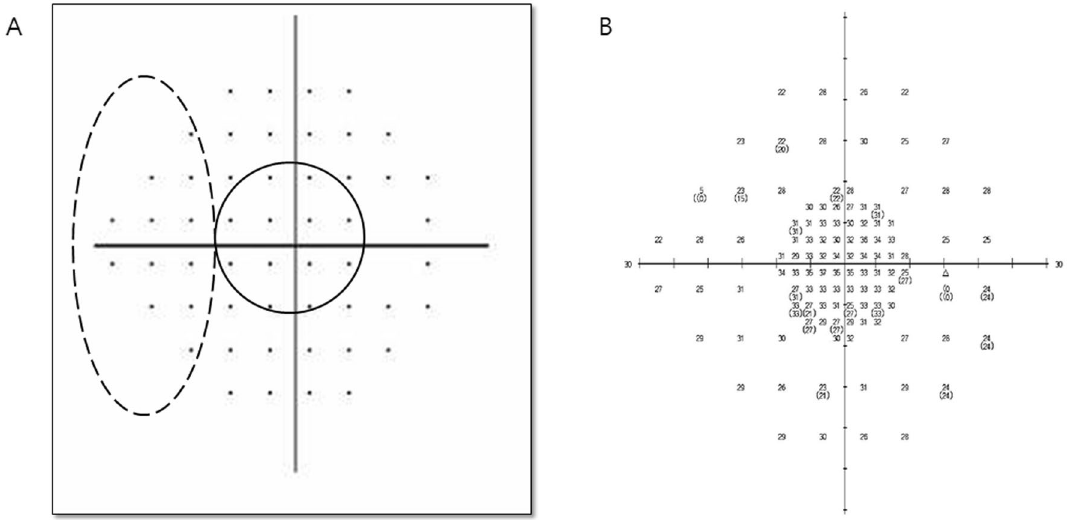
Figure 1. ( A ) Paracentral scotoma (12 points within the dashed line) and peripheral nasal step (12 points within the dotted line) shown in the PSD plot of the 24-2 VF test ( B ) Representative simultaneously performed combined 24-2 and 10-2 VF